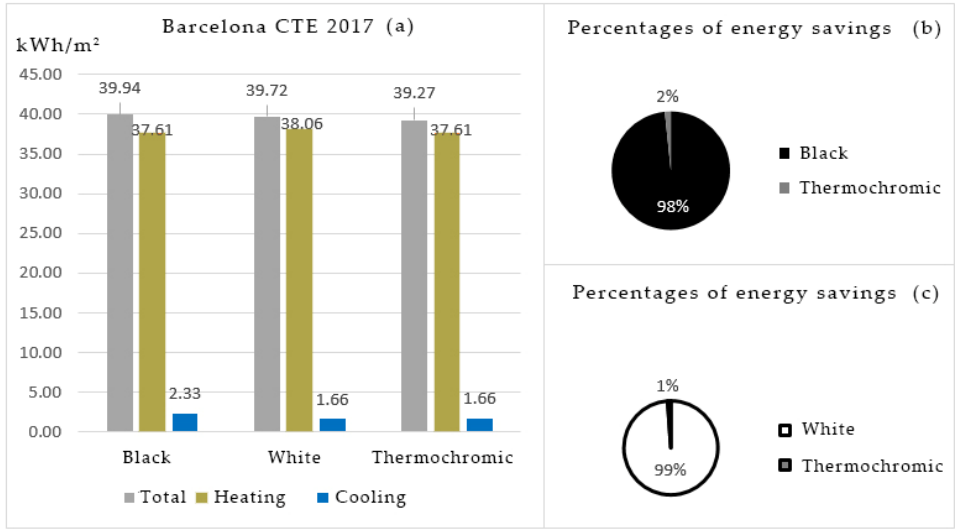
Figure 10. ( a ) Energy demand for heating and cooling in the case of Barcelona CTE 2017. ( b ) Thermochromic vs. black surface finish energy savings. ( c ) Thermochromic vs. white surface finish energy savings.